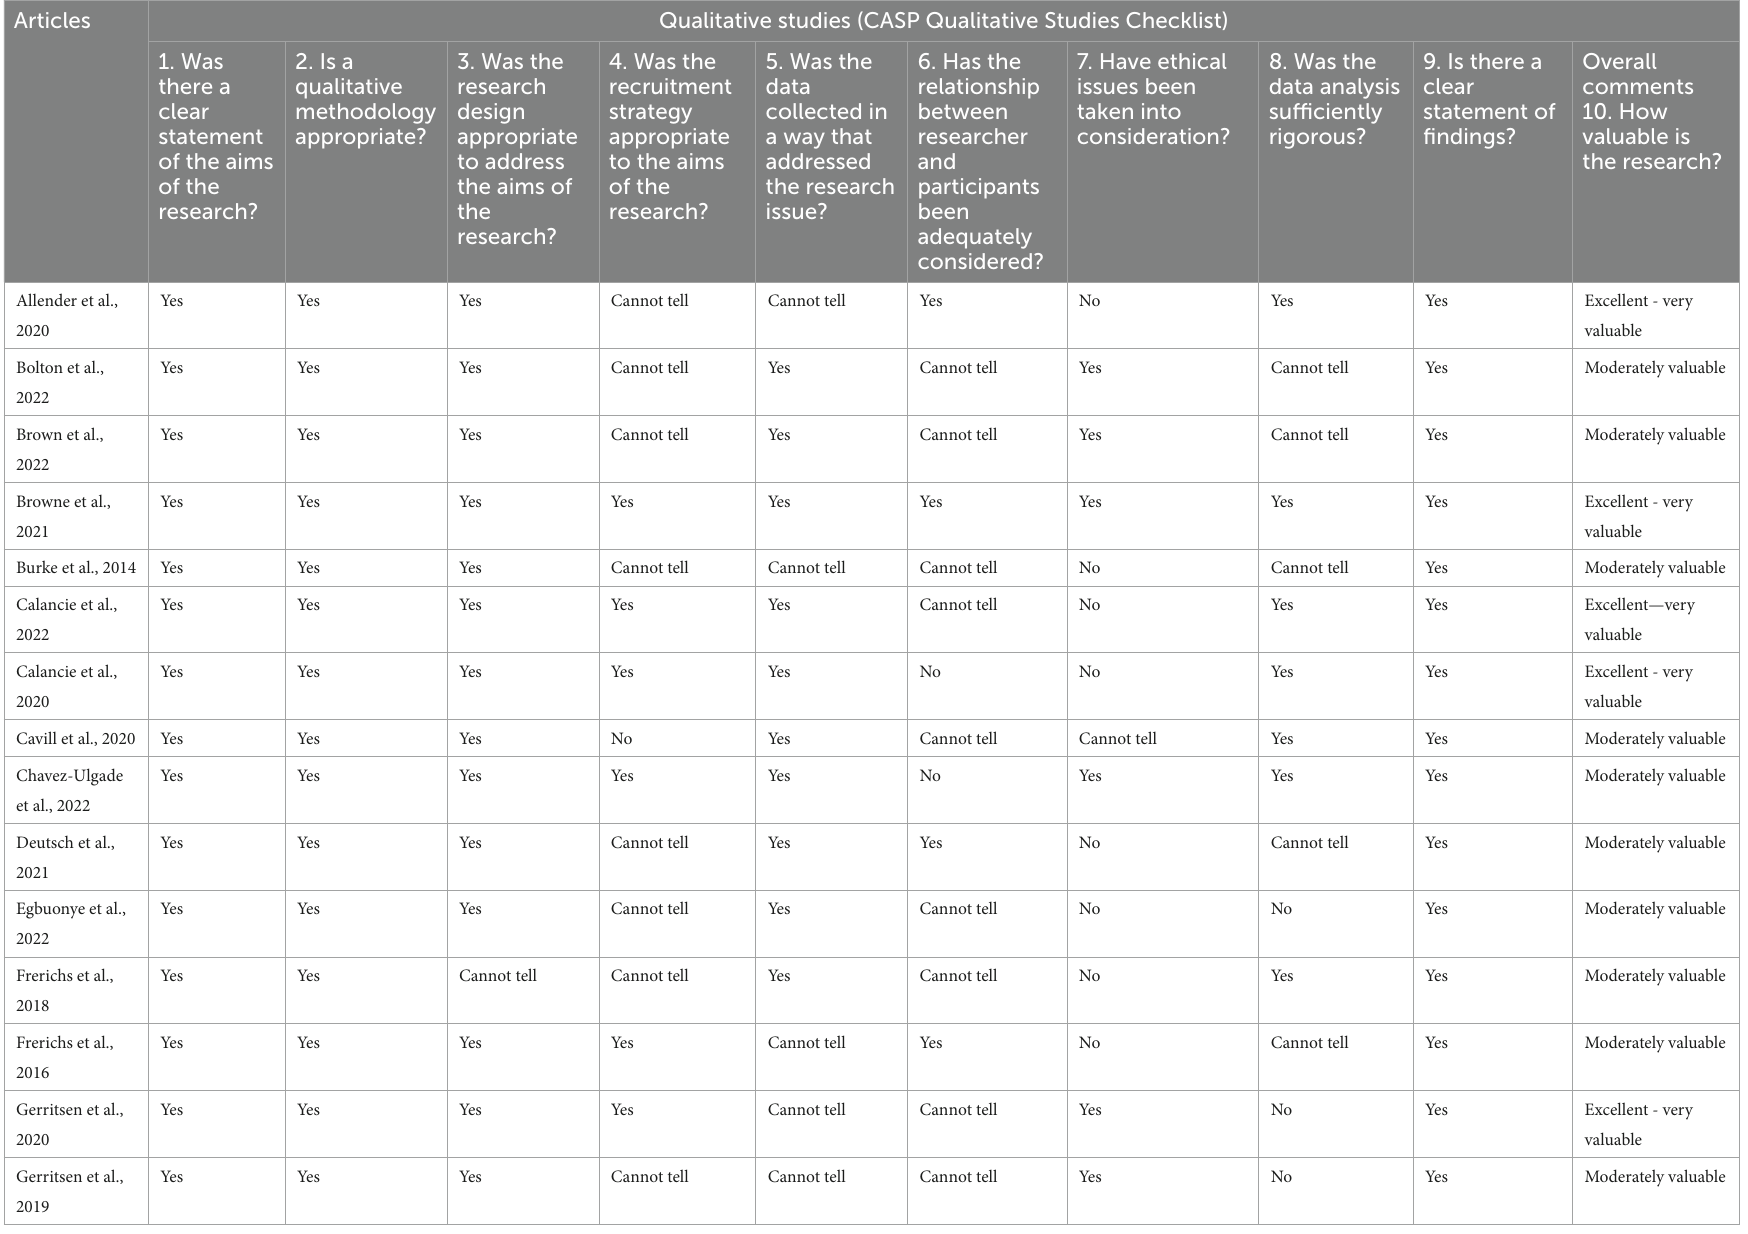
TABLE 2 Summary of quality assessment for included